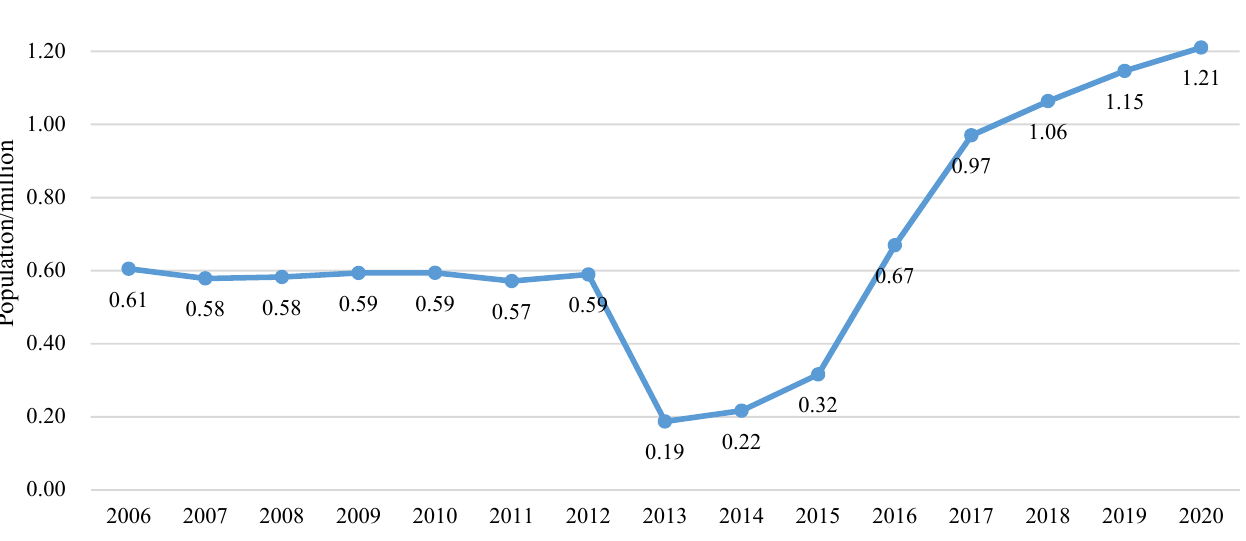
Figure 2. Refugee population in Germany (2006–2020). Source from Our World in Data, line graph made by